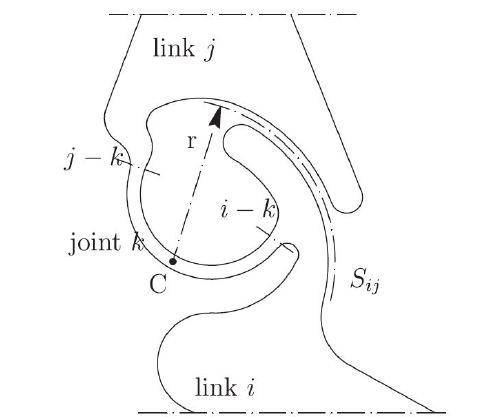
Figure 7. Flexural hinge geometry (see also Refs.